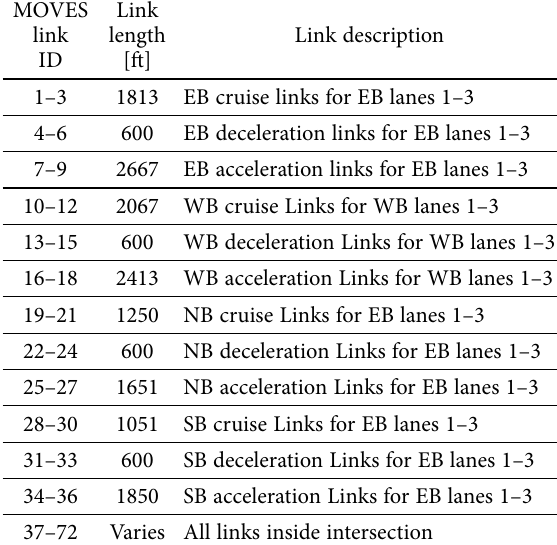
Fig. 4. MOVES link definition for the ACUTA intersection Table 1. MOVEs Link definitions and